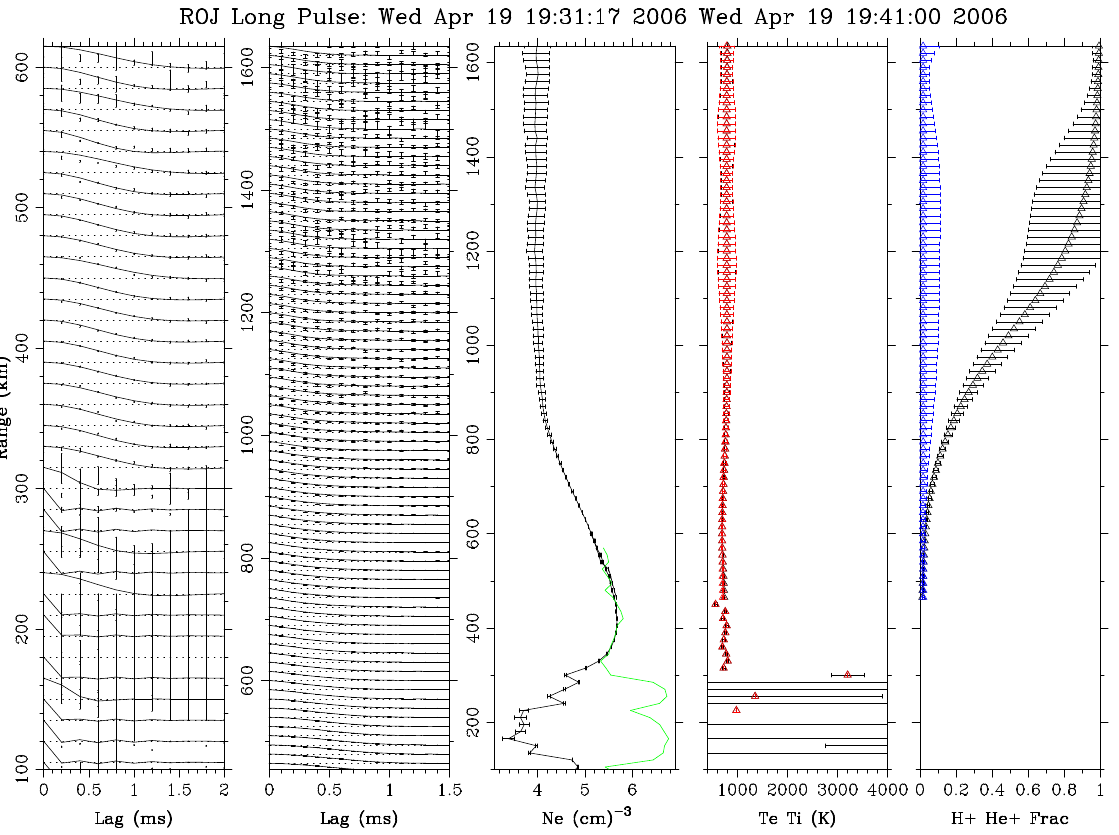
Fig. 3. Jicamarca profiles for 19:30 LT (00:30 UT). From left to right, the panels represent double-pulse lag products, long-pulse lag products, electron density, electron and ion temperature, and light ion fraction (see